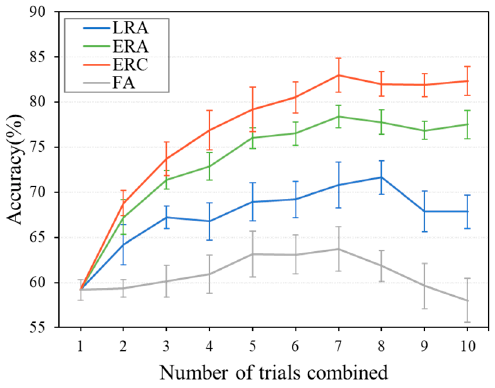
Figure 10. Accuracies of different combination strategies. FA is fixed averaging strategy.